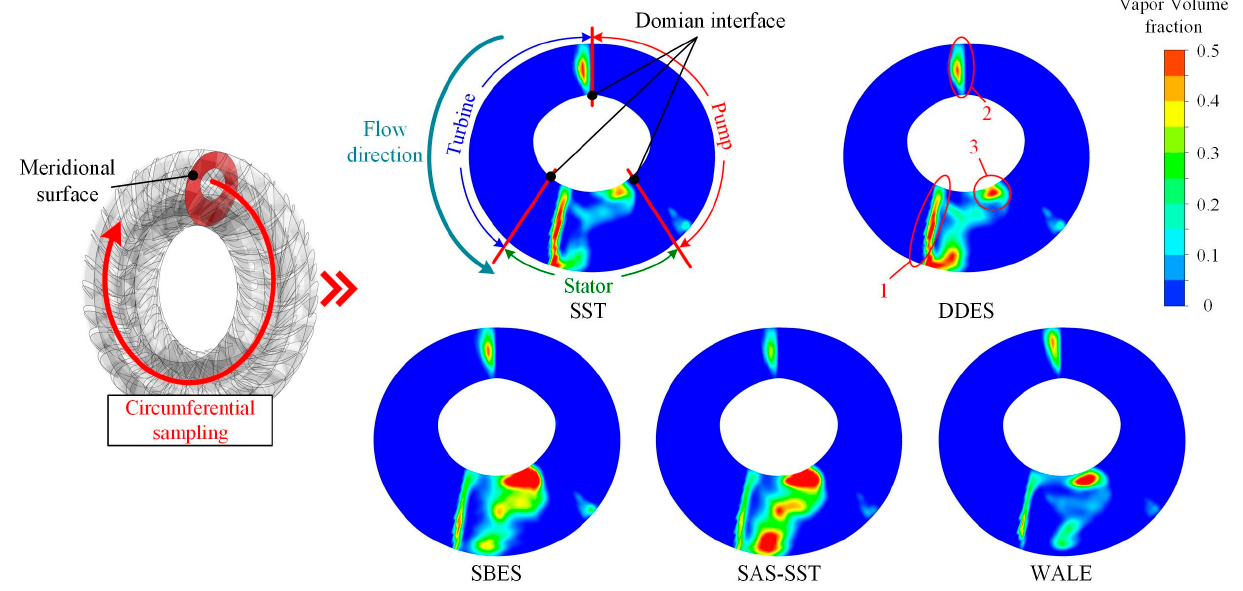
Figure 11. Meridional vapor volume fraction distribution under various models ( SR = 0.01).